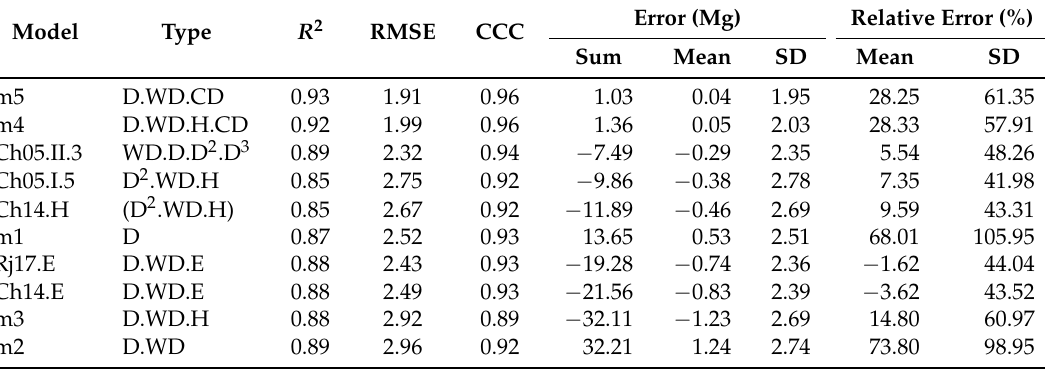
Table 4. Summary of AGB estimates from TLS-derived and pantropical allometric models— R 2 , root mean square error (RMSE), concordance correlation coefficient (CCC), sum of errors (sum, mean, standard deviation (SD)), mean percent error and relative error ( n = 26). Models are arranged based on the statistical parameters from the best model to the worst